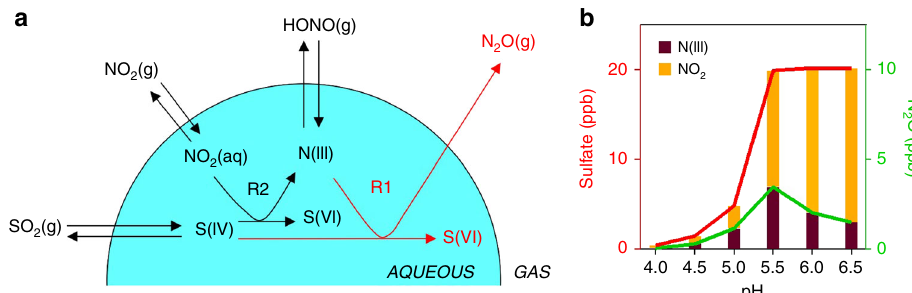
Fig. 4 SO 2 oxidation mechanism. a Illustration of the mechanism for SO 2 oxidation to sulfate by NO 2 and HONO in fog and cloud. Here S(IV) ≡ SO 2 ∙ H20 − + SO − + SO + HSO ≡ H + HSO 2 − denotes the different forms of dissolved SO 2 − denotes the different forms of sulfate, and N 3 3 2 , S(VI) 2 SO 4 (aq) 4 4 (III) ≡ HNO 2 (aq) + NO 2 − denotes the different forms of dissolved HONO. S(IV) is oxidized in the aqueous phase by dissolved NO 2 (reaction (R2)), producing N(III) which may oxidize additional S(IV) and produce N 2 O by reaction (R1). b pH-dependent sulfate and N 2 O production from the (R2) + (R1) mechanism. The plot shows accumulated concentrations of sulfate and N 2 O after 5 h in a nighttime fog air parcel simulation initialized with [SO 2 ] = 20 ppb, [NO 2 ] = 80 ppb, and [HONO] = 5 ppb, with a fog LWC = 0.15 g m − 3 and T = 271 K. Contributions from aqueous-phase SO 2 oxidation by HONO (reaction (R1)) and NO 2 (reaction (R2)) are shown separately. A sulfate production of 20 ppb implies complete oxidation of SO 2 over the